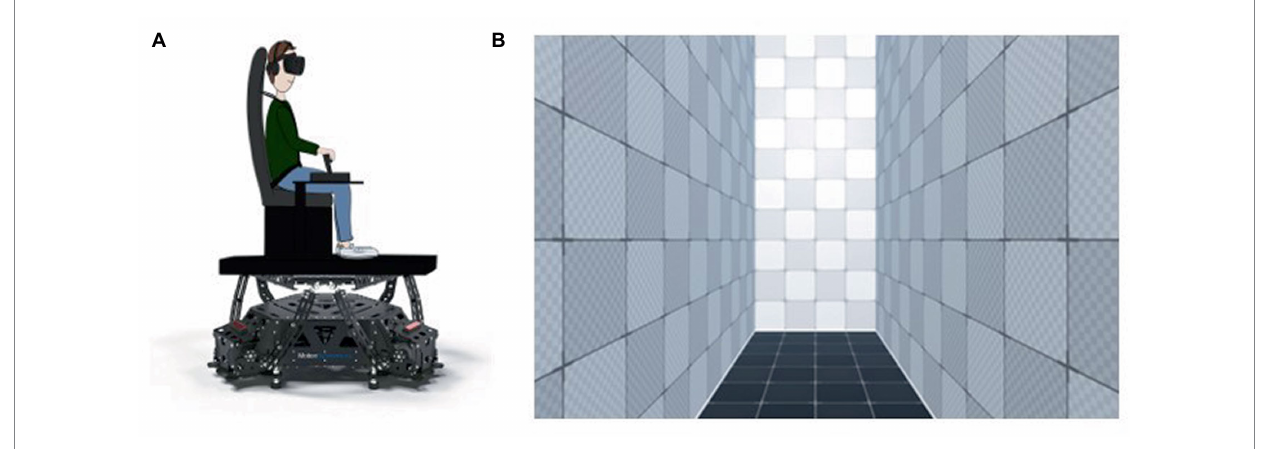
FIGURE 1 (A) Schematic representation of the setup, (B) Virtual